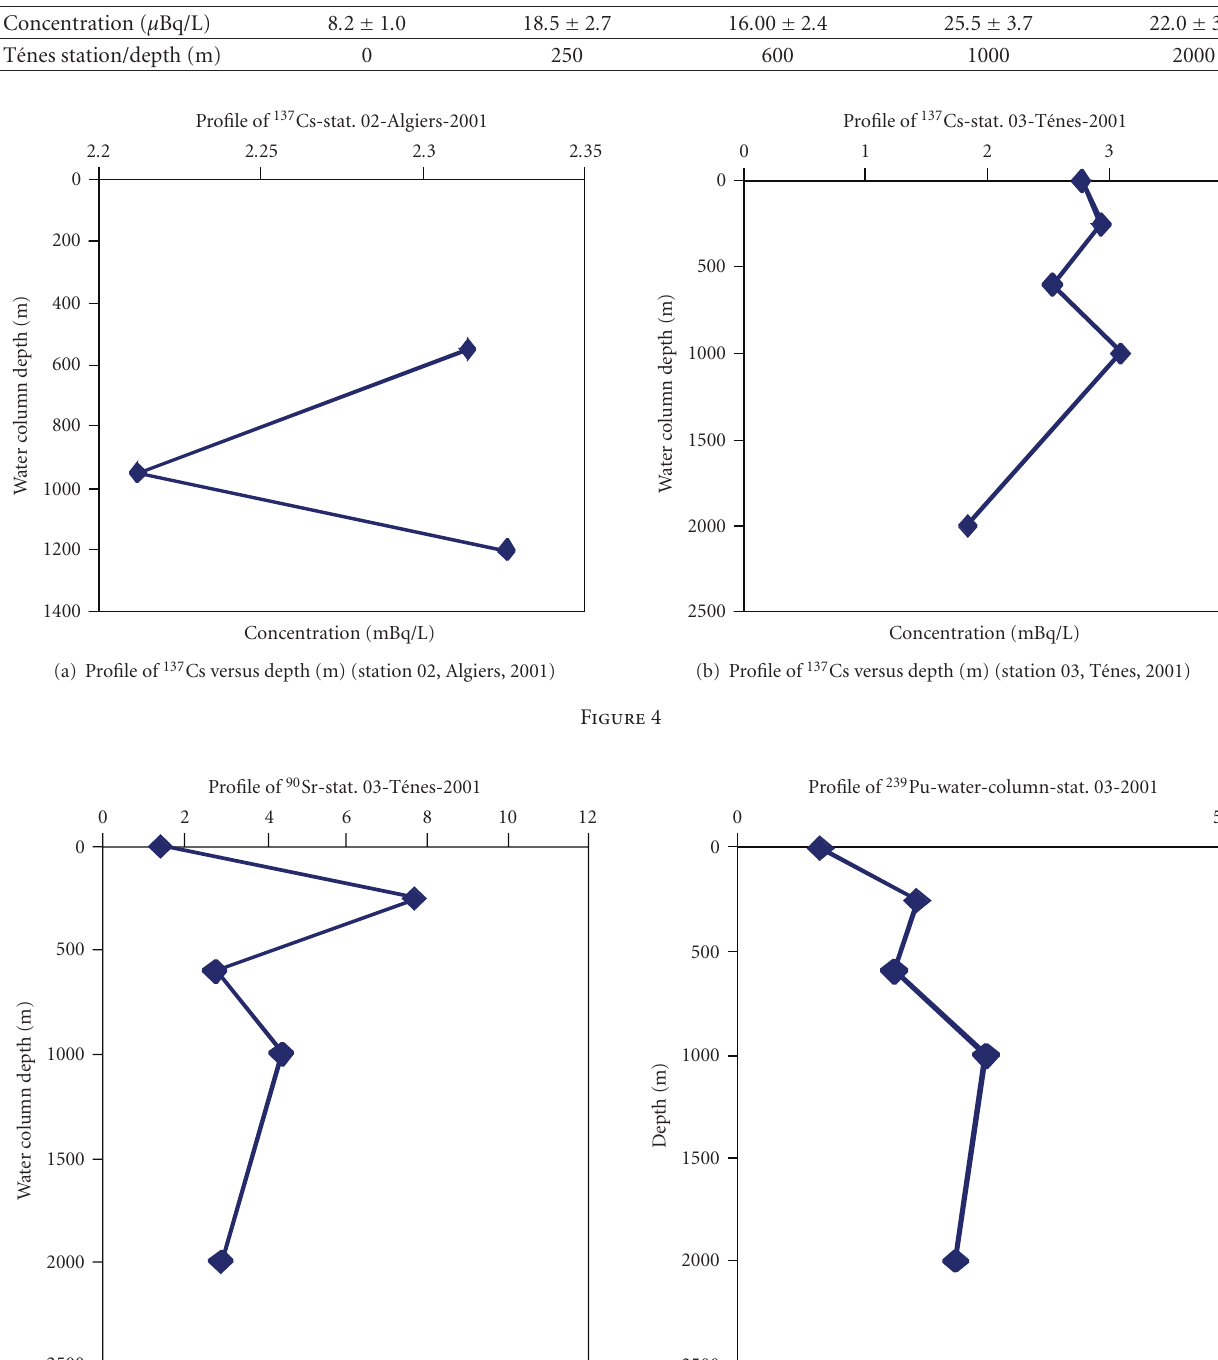
Table 4: Concentration of 239+240 Pu along seawater column of T´enes station,